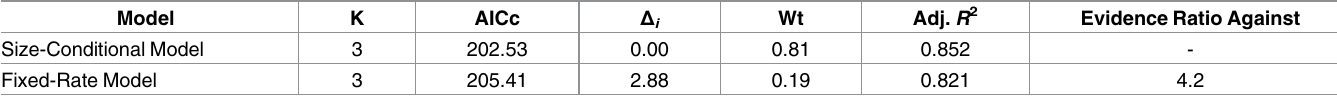
K, number of parameters in model; AICc, Akaike’s Information Criterion, corrected for small samples; Δ i , difference from AICc of best model; Wt, Akaike weight.